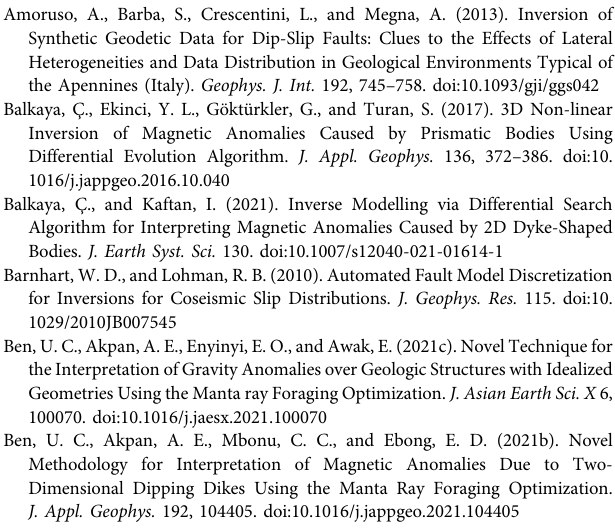
algorithm execution rate was impressive- fi nding